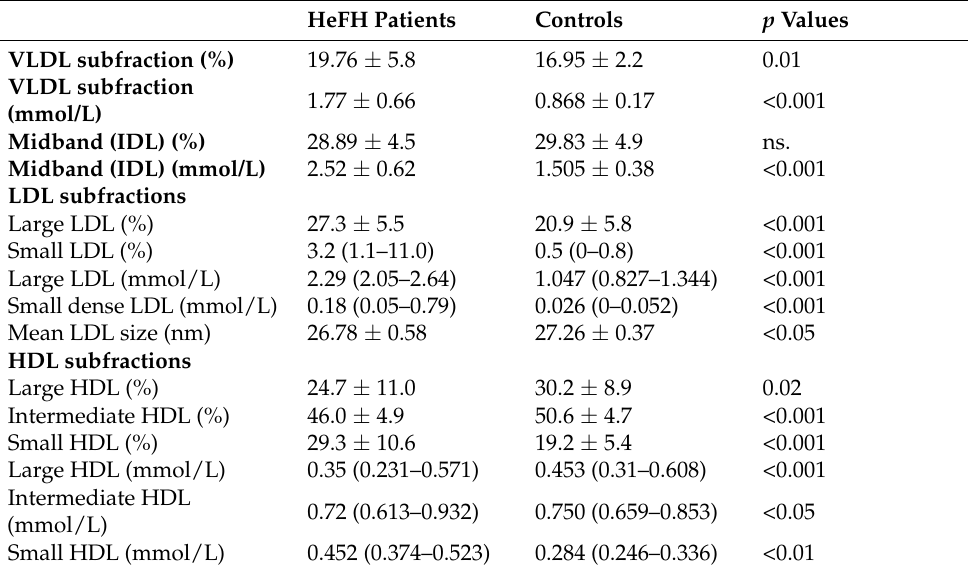
Table 2. The concentrations of lipoprotein subfractions in the study participants. The values are presented as mean ± standard deviation or median (lower quartile–upper